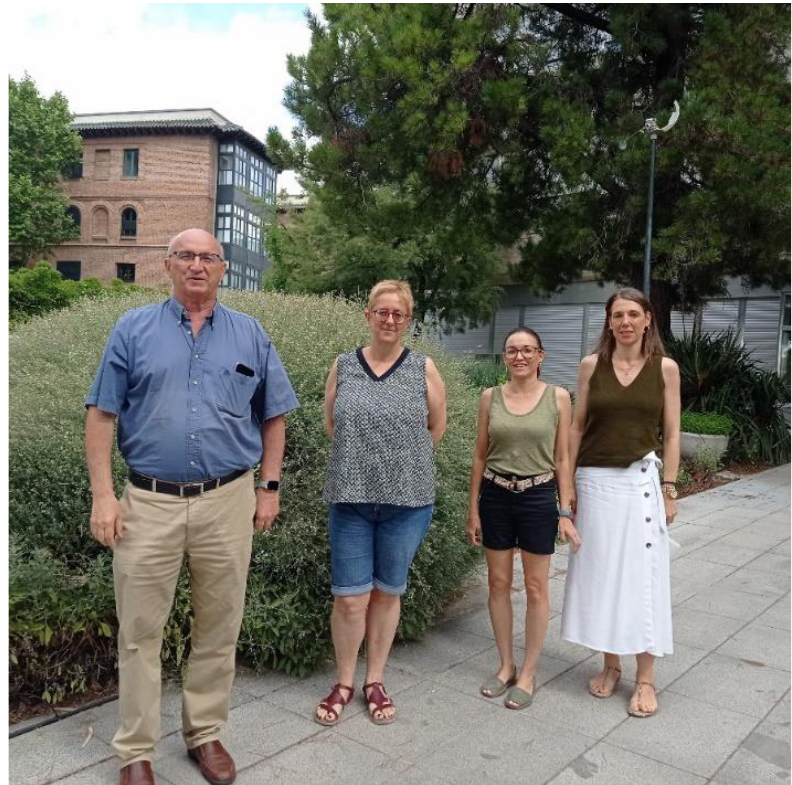
Figure 3. A photo of authors of the article “Feeding Behavior and Virus-transmission Ability of Insect Vectors Exposed to Systemic Insecticides”.